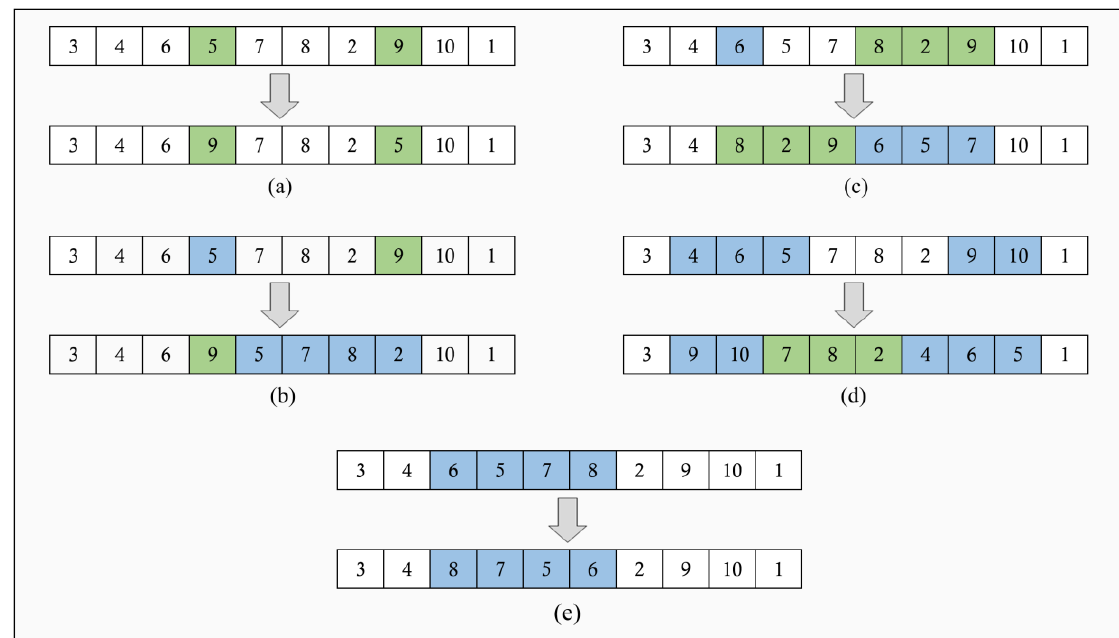
Figure 5. Permutation operators: ( a ) Exchange, ( b ) Relocate, ( c ) OrOpt, ( d ) TwoOpt, and ( e ) Reverse. The selected variables for change are shown in colors.